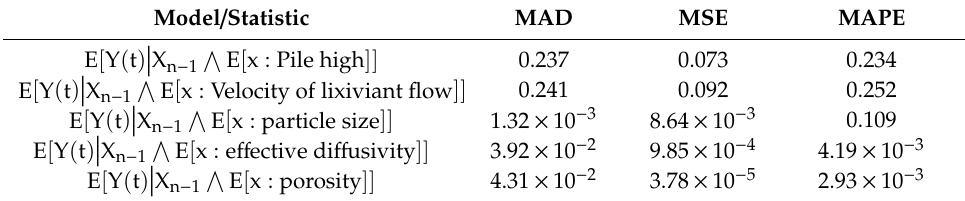
Table 3. Statistics of the analytical model of leaching of marine